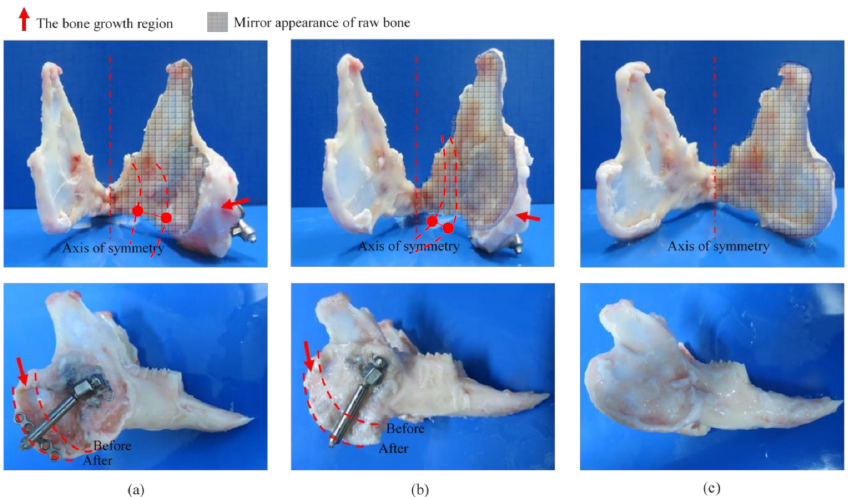
Figure 5. The variations in bone growth geometric shape observed in Groups TMB ( a ), TM ( b ) and TC ( c ) at the mandible angulus from back and lateral views were recorded. Buccal side thickness of the angulus after distraction was also calculated to compare the variations between Groups TMB and TM.